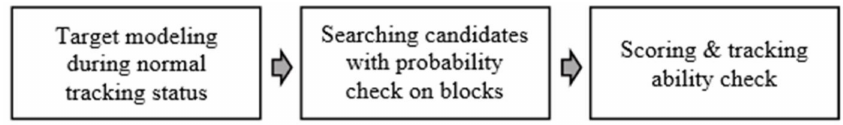
Figure 13. Procedure of target re-locking.